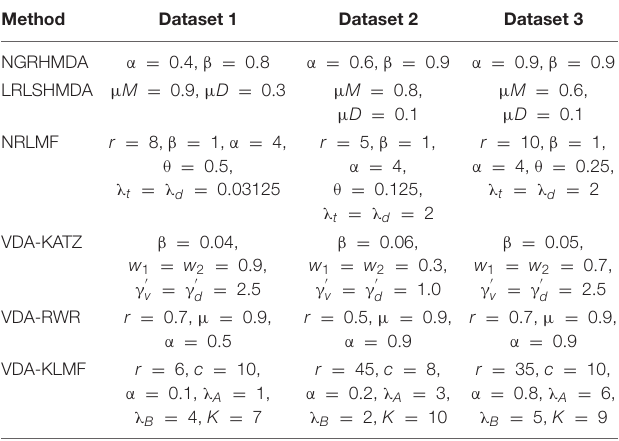
TABLE 2 | The optimal parameter combinations of six VDA prediction methods.